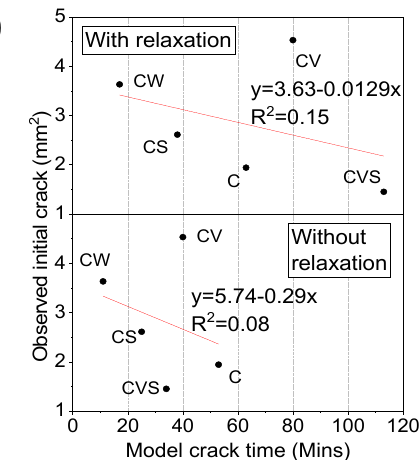
Figure 15. (a) Strain path analysis using vM ‐ H theory with strain dissipation, and (b) without strain dissipation; (c) relationship between the model outputs and observed cracking (d) relationship between the stress path model outputs and observed cracking ( 𝛾 (cid:3040)(cid:3028)(cid:3051) / 𝜀 (cid:2869) , 𝜀 (cid:2870) – principal shear/normal strains, 𝛾 (cid:3046) – strain capacity, vM ‐ H – von mises & Hencky strain